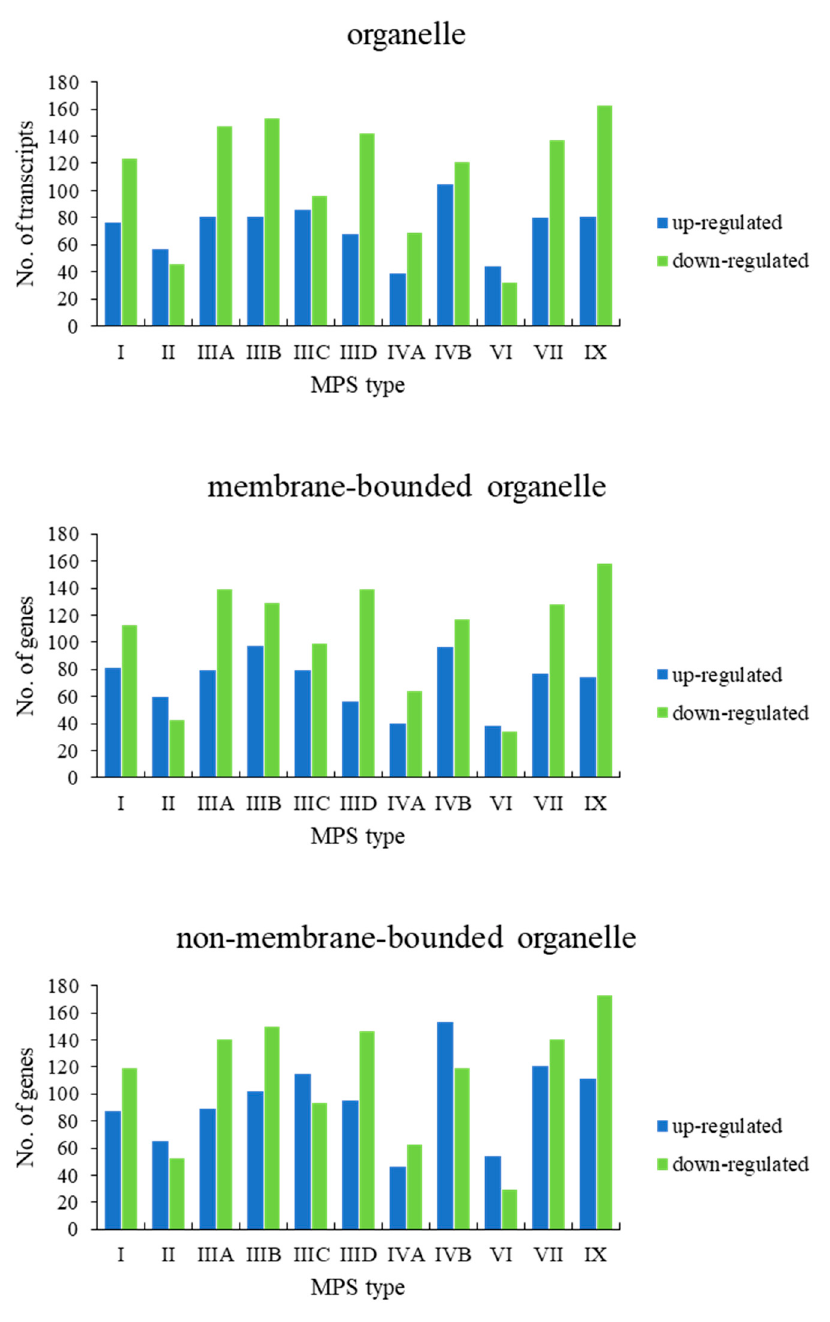
Figure 3. Number of up- and downregulated transcripts (at FDR < 0.1; p < 0.1) with division into selected organelles (child terms of ‘cellular anatomical entity) in different MPS types relative to control cells (HDFa).